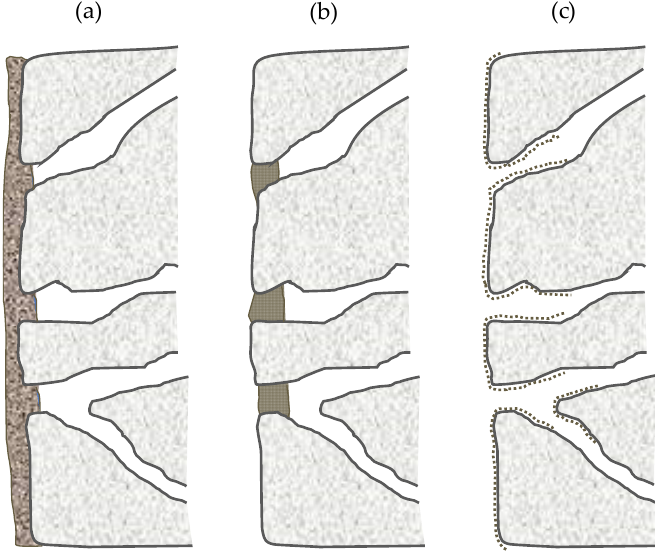
Figure 3. Typologies of hydrophobic surface treatments on concrete: ( a ) coating; ( b ) pore blockage; and ( c ) impregnation. Table 1. Summary of main compounds employed in hydrophobic surface treatments.